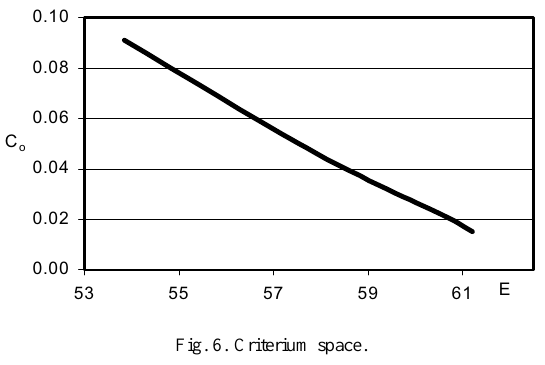
Fig. 6. Criterium